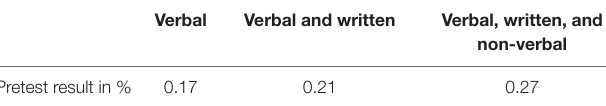
TABLE 1 | Correlations (Bravais–Pearson) between pre-test results and coding results. Verbal Verbal and written Verbal, written, and